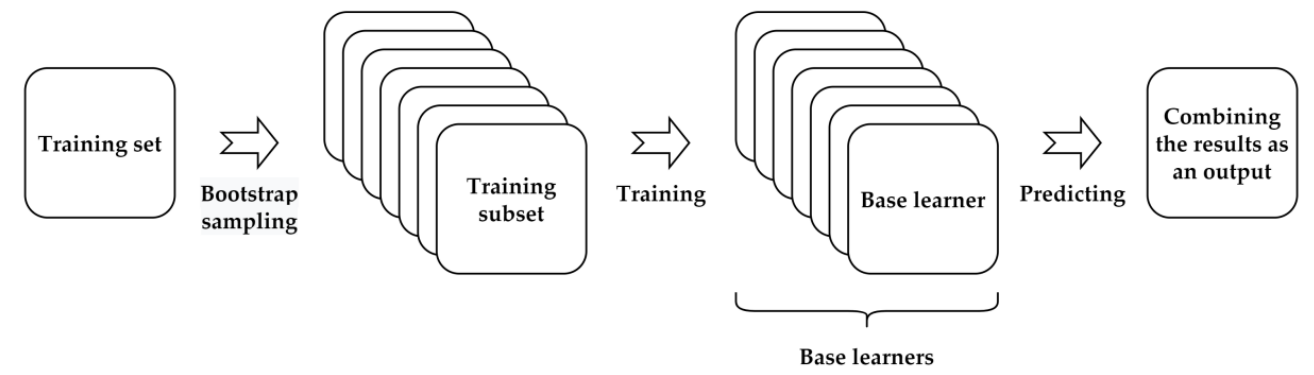
Figure 4. The mechanism of bagging